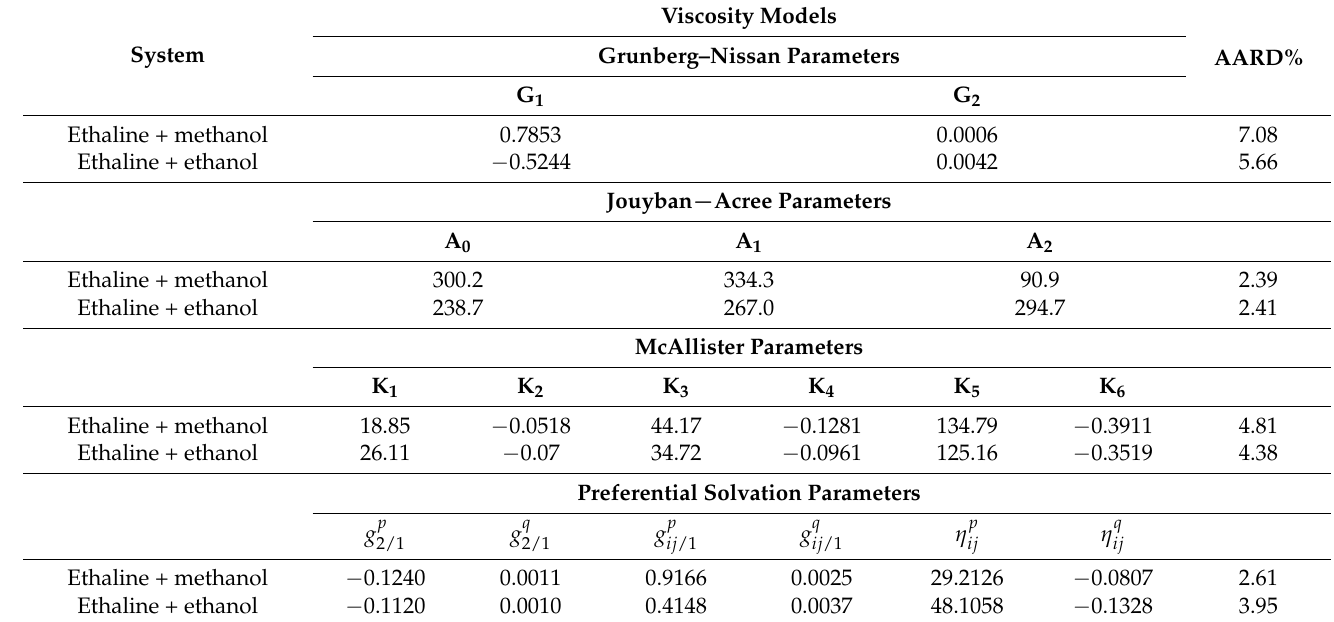
Table 5. The optimized values of adjustable parameters and AARD% values for the Grunberg–Nissan [20], Jouyban–Acree [21], McAllister [22], and Preferential Solvation [23,24] models for viscosity estimation of Ethaline (1 ChCl:2 ethylene glycol) + methanol/ethanol systems at a pressure of 100